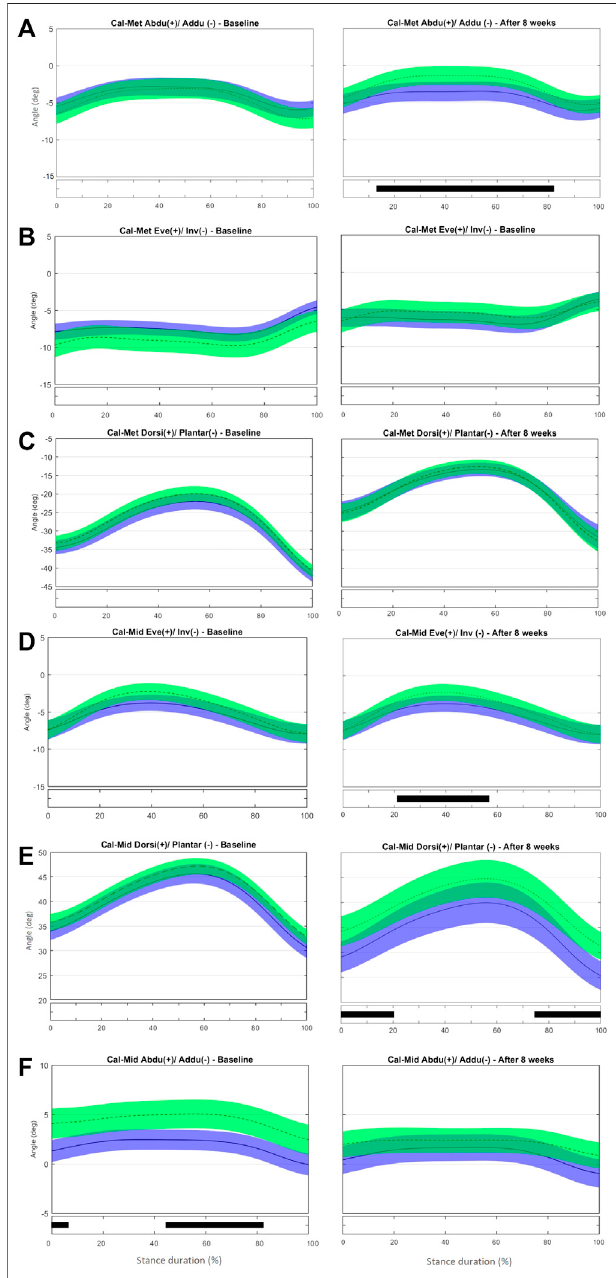
FIGURE 4 | Mean (±1SD) joint rotation angles during normalized stance phasedurationofrunninginthebaseline(left)andafter8 weeksofintervention (right). From top to bottom: transverse-plane rotations between metatarsus and calcaneus (A) , frontal-plane rotations between metatarsus and calcaneus (B) , sagittal-plane rotations between metatarsus and calcaneus (C) , frontal-plane rotationsbetween midfoot and calcaneus (D) , sagittal-plane rotations between midfoot and calcaneus (E) , and transverse-plane rotations midfoot and calcaneus (F) . Green, CG group; Blue, IG group. The black bar belowthegraphrepresentsthetimeduringwhichthedifferencesbetweenthe groups occurred ( p < 0.05), what was indicated by the SPM{t} statistics.